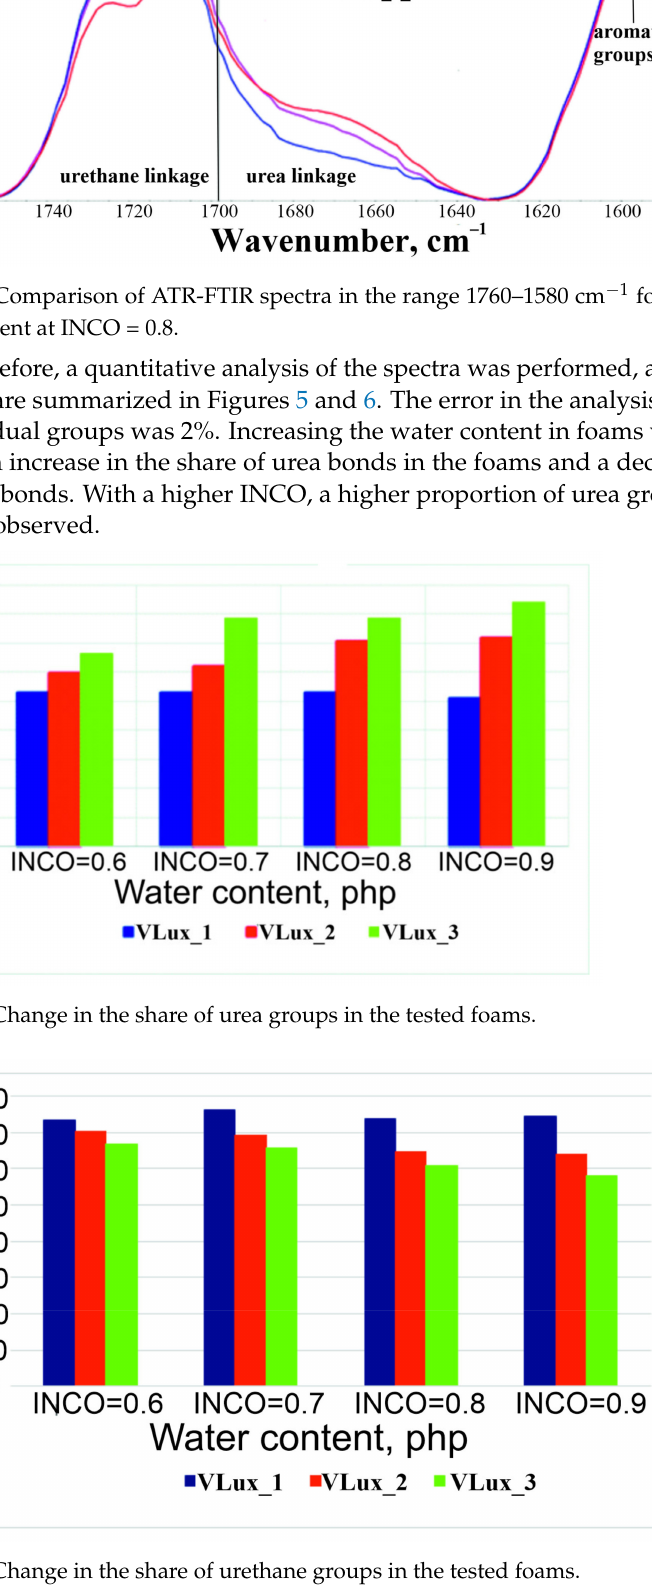
Figure 6. Change in the share of urethane groups in the tested